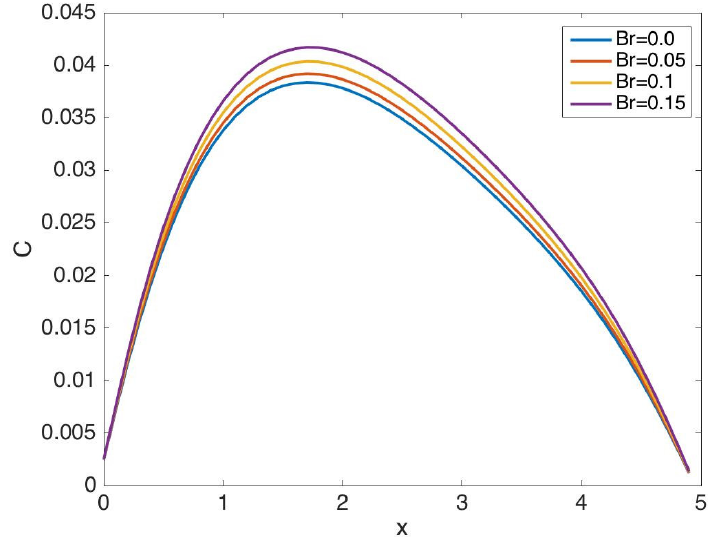
Figure 6. Concentration profiles against the x -axis at y = 1 m, for various values of Br of Case 1. (cid:113) The pressure and velocity magnitude ( = + ) profiles are plotted in Figure 7a,b, respectively, against the x -axis at y = 1 m, for various values of Br of Case 1. These figures show that, as Br increases, pressure and velocity increase. The maximum differences are located in the inlet vicinity and gradually decrease far away from it.